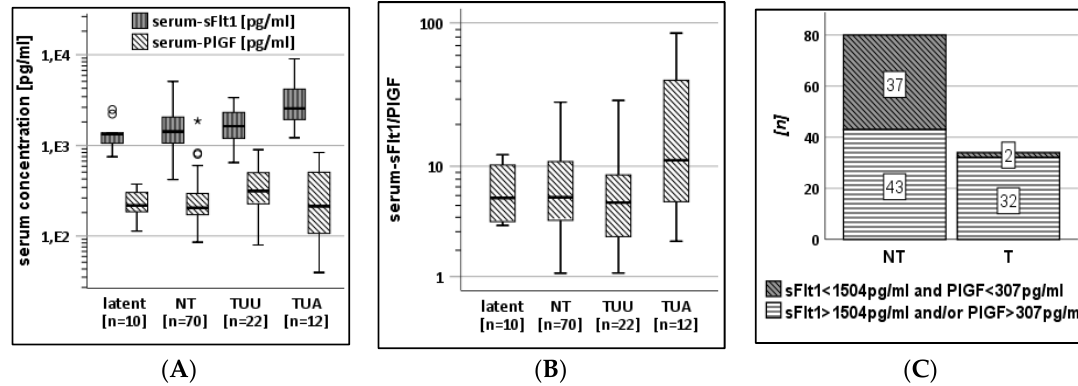
Figure 2. ( A ). Serum sFlt1 and PlGF concentrations in subcohorts divided by non-transmitters, transmitters without ultrasound unsuspicious for CMV (T UU ) compared with latently infected, and a subcohort of women with ultrasound abnormalities (T UA ) associated with fetal CMV infection. ( B ). Serum sFlt1/PlGF ratio in subcohorts according to transmission status and ultrasound findings revealing significant differences between the subcohort T UA compared with T UU and NT, respectively. ( C ). Frequency of samples below and above empirical cut-off values for PlGF and sFlt1 separated by transmission status at AC. Transmission is more frequently associated with sFlt1 or PlGF concentrations above 1504 pg/mL and 307 pg/mL,